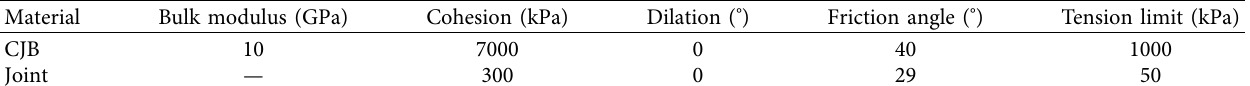
Figure 9: Different joint angles and thickness of weakness in CJB employed in numerical simulation of uniaxial compression. Table 2: Mohr–Coulomb and ubiquitous-joint properties used in numerical simulation.